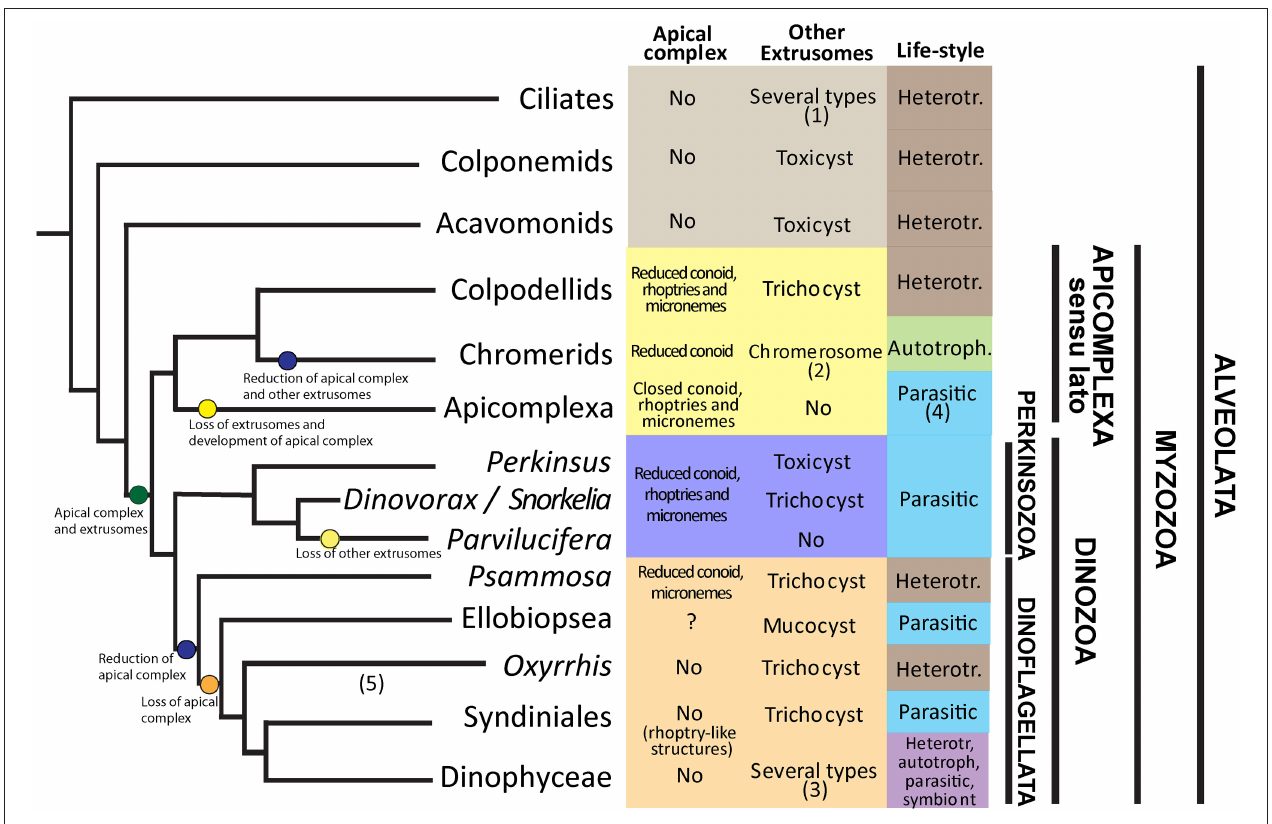
FIGURE 8 | Framework of extrusomes, apical complex and life-style evolution among Alveolates. (1) Trichocysts, mucocysts, toxicysts among others. (2) Chromerosome shows similitude with toxicysts. (3) Trichocysts, mucocysts, taeniocysts, nematocysts. (4) Parasitic, but present the apicoplast, a plastid relic. (5) The phylogenetic position is based on Bachvaroff et al. (2014) and Janouškovec et al. (2017). Heterotr. =